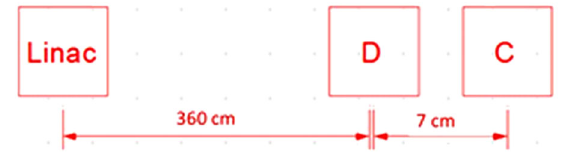
FIG. 5. Setup for the one-step correction. D is the position for velocity diagnostic and C is the position for the velocity